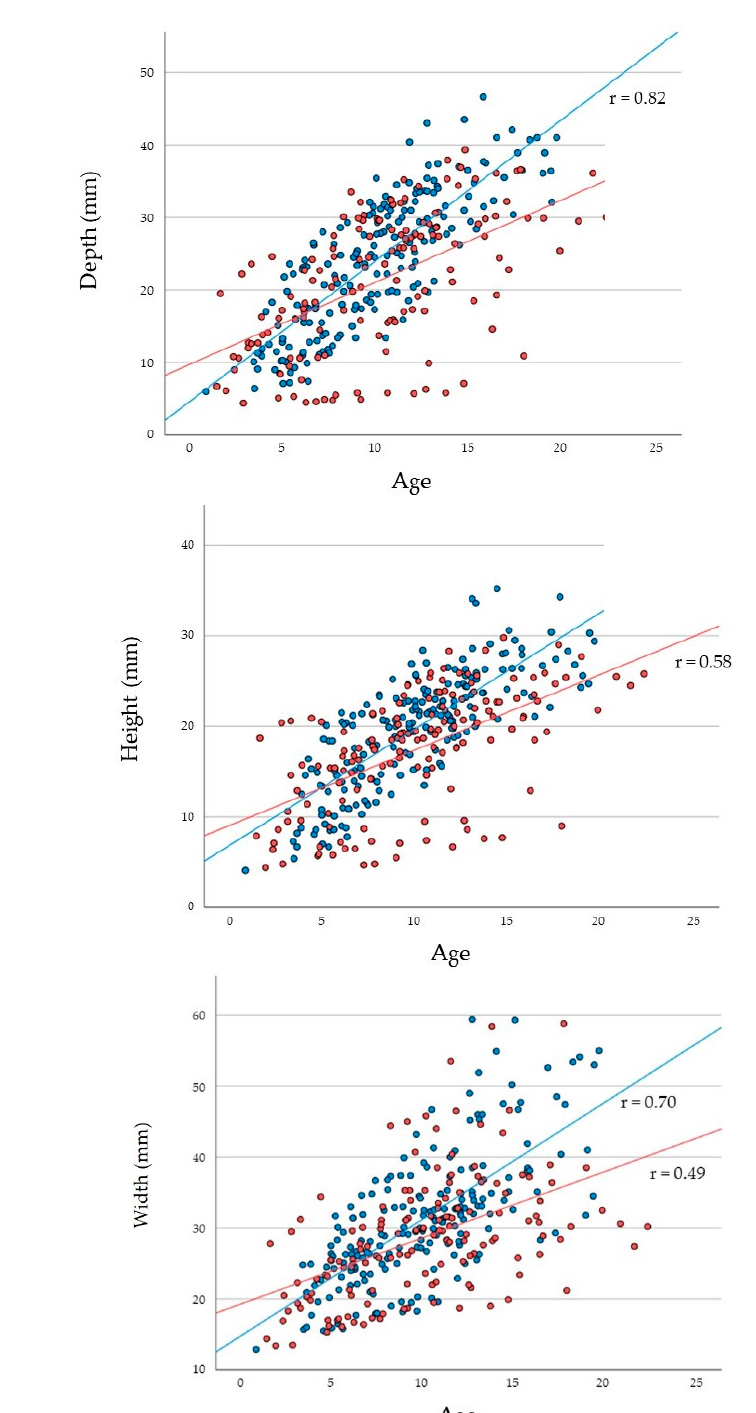
Figure 4. Scatter plots with linear single regression lines between the depth of the sphenoid sinus at different ages ( a ); between the height of the sphenoid sinus and age ( b ); and between the width of the sphenoid sinus and age ( c ) for each sex. Red plots and lines indicate females, while blue plots and lines indicate males.